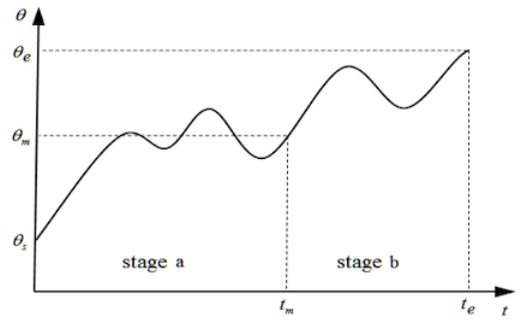
Figure 3. Two-stage quintic curve of a joint